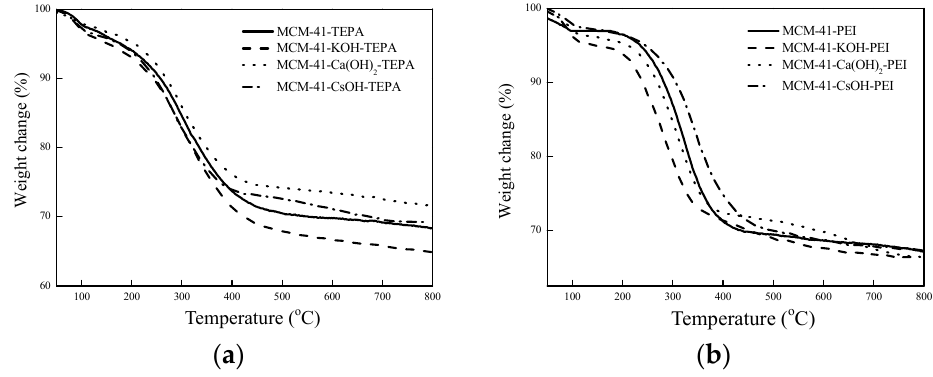
Figure 3. TGA curves of MCM ‐ 41 modified by ( a ) TEPA ( b ) PEI and various alkali components.